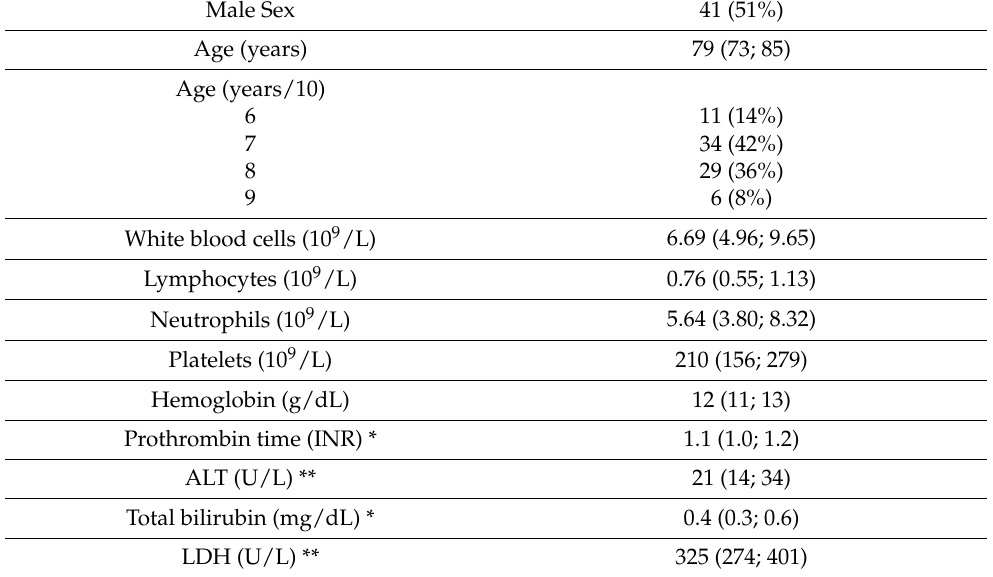
Table 1. Baseline features of the